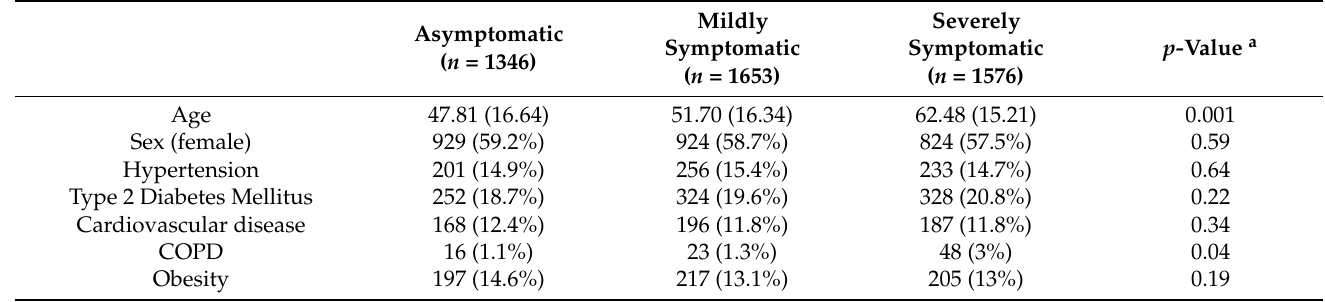
Table 1. Demographics and comorbidity characteristics of COVID-19 patients.